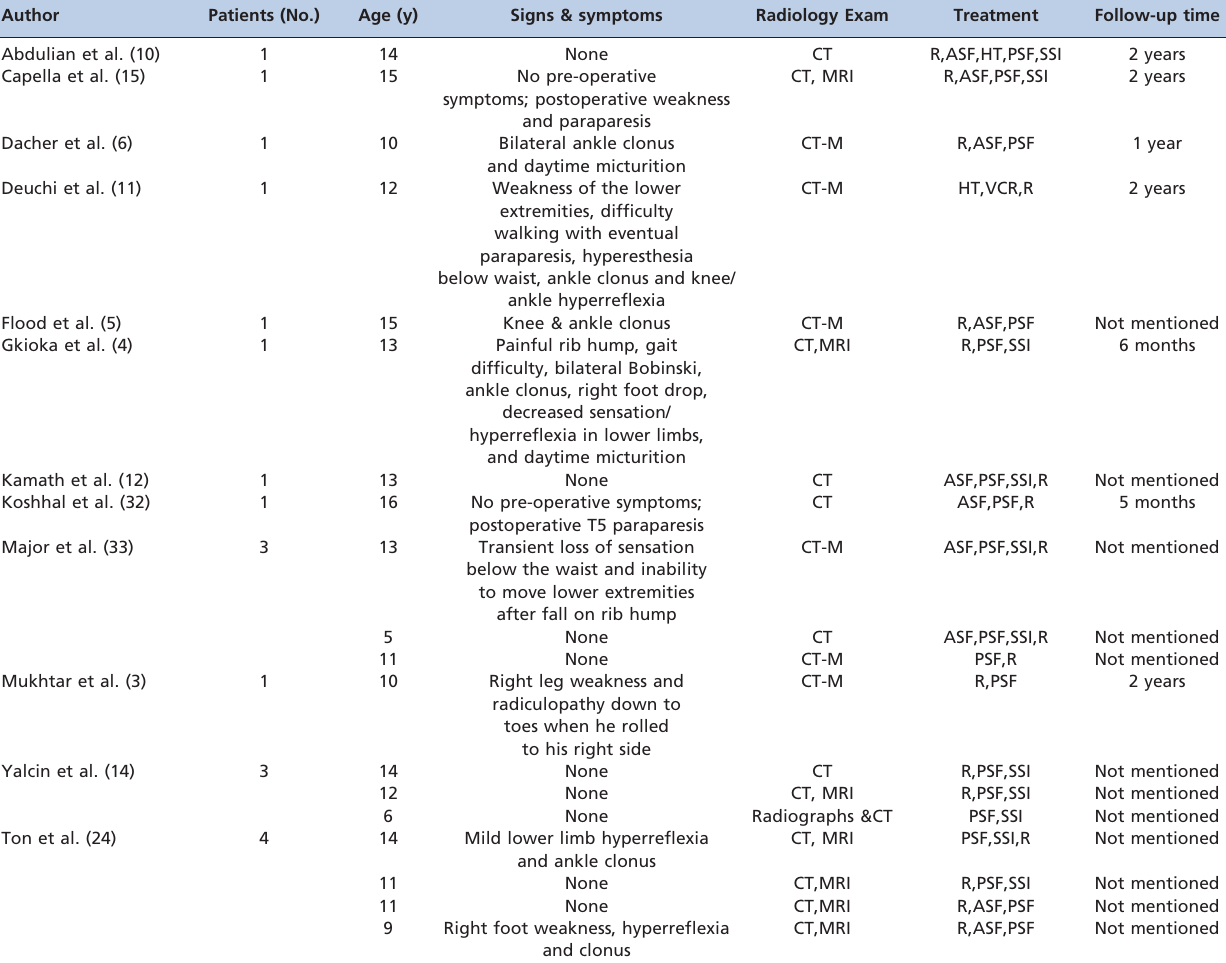
Table 1 - Previous Reports of Spinal Canal Rib Penetration in Patients With Neurofibromatosis